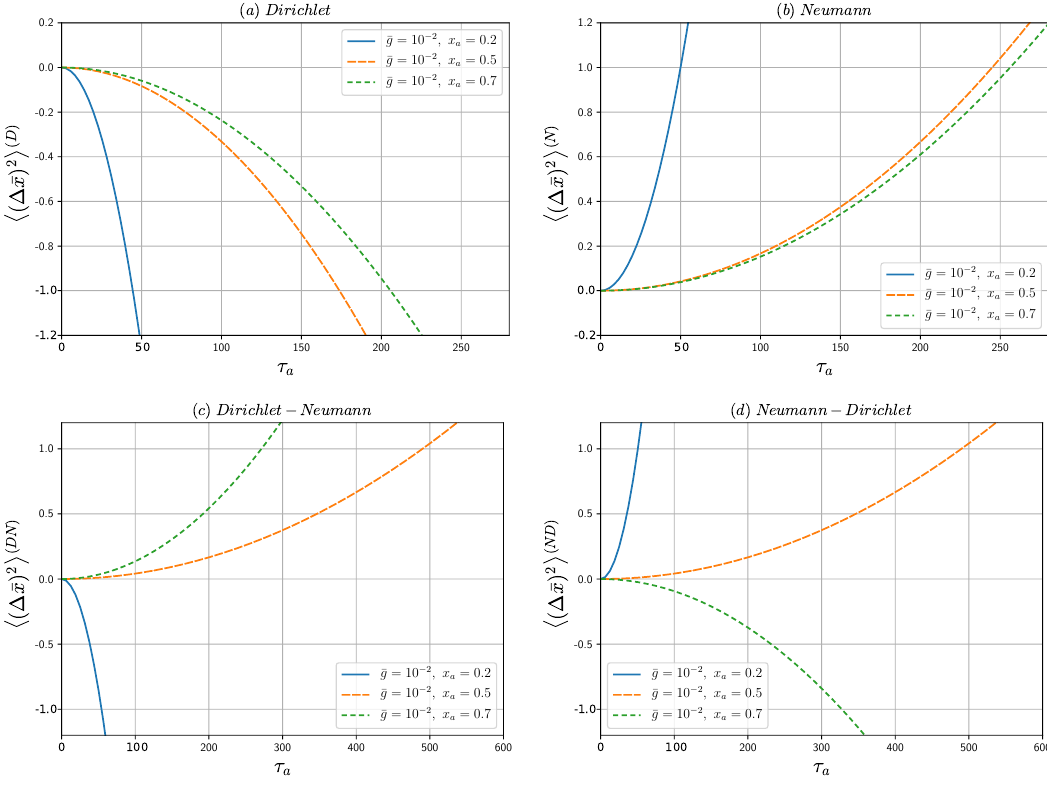
Figure 8 . Relative dispersion for the position coordinate perpendicular to the planes for (a) Dirichlet, (b) Neumann, (c) Dirichlet-Neumann and (d) Neumann-Dirichlet conditions, with ¯ g = g = 10 − 2 and different values of x a . For simplicity, we have defined h (∆¯ x ) 2 i (j) := ma